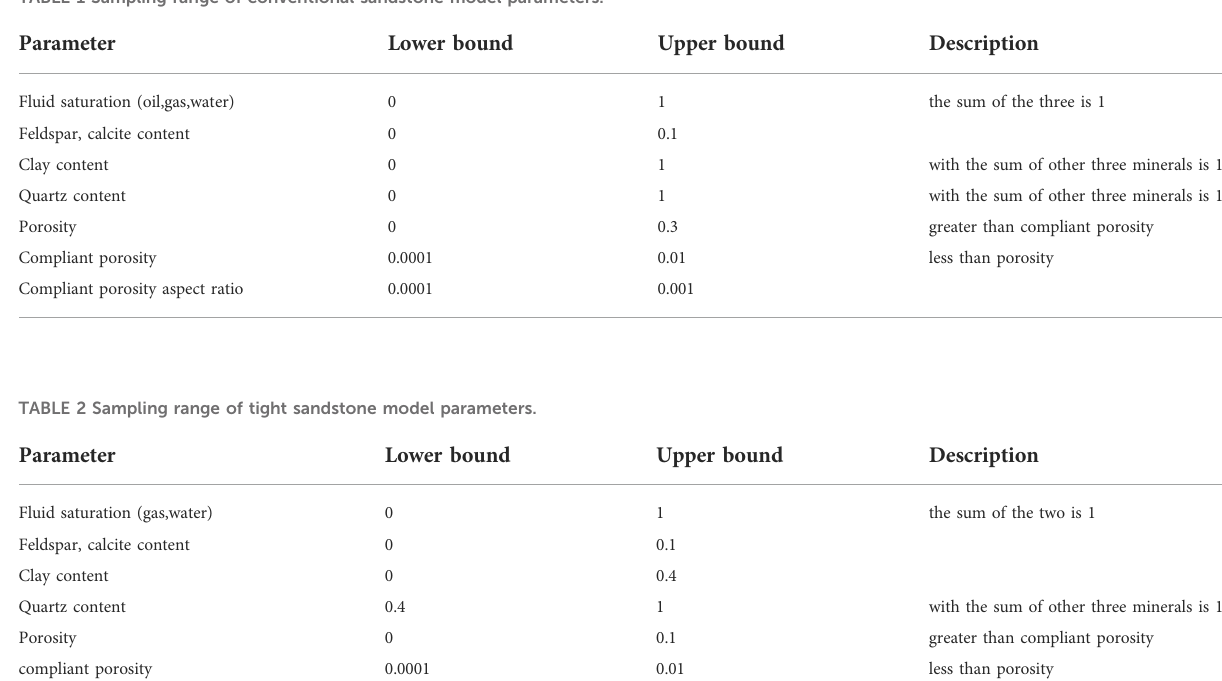
TABLE 1 Sampling range of conventional sandstone model parameters.